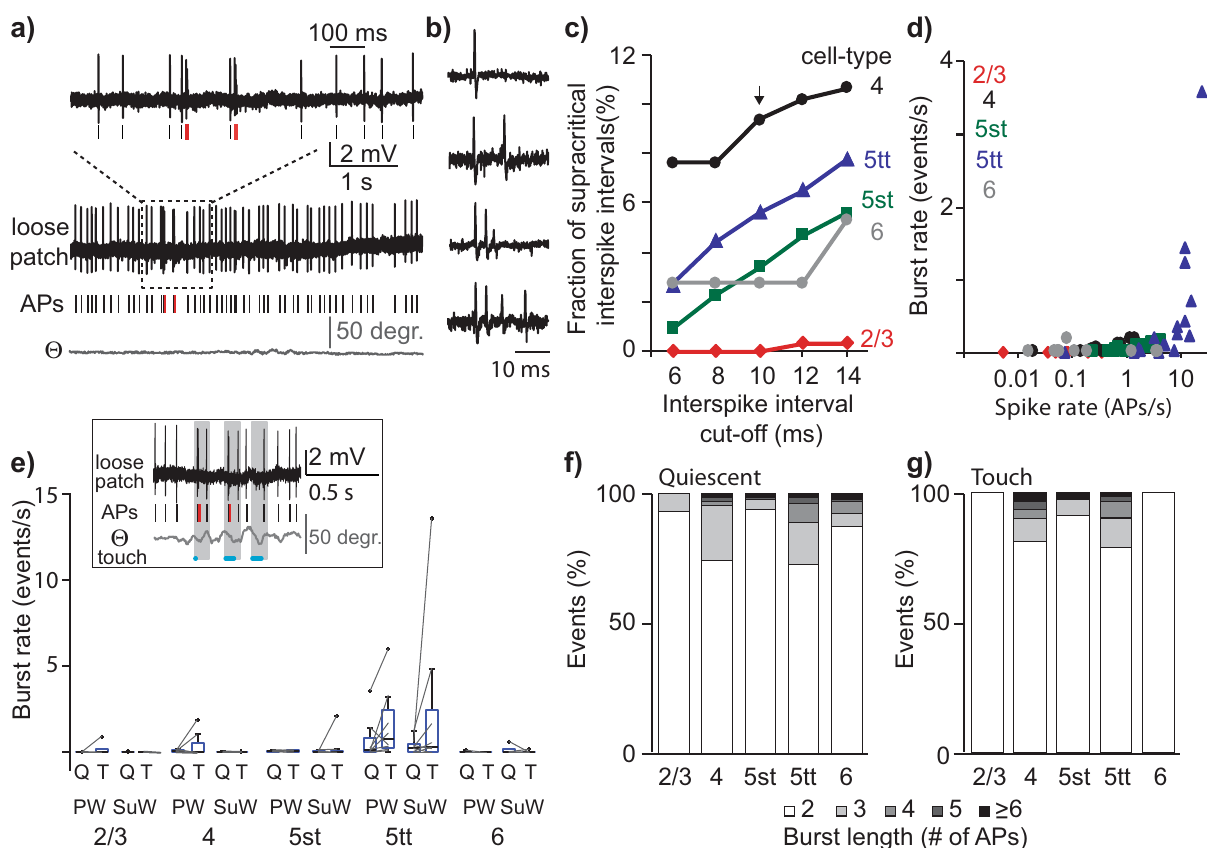
Fig. 4 Cell-type-speci fi c high-frequency bursting. a Spiking activity of an example L5tt recording during quiescent episodes with single spikes indicated by black ticks and spikes at supracritical frequency ( ≥ 100 Hz) by red ticks, respectively. b Example traces of a single spike (upper trace) and burst events of 2 – 4 consecutive spikes at supracritical frequency ( ≥ 100 Hz). c The median fraction of high-frequency bursts detected during spontaneous spiking activity (quiescent episodes) depends on the cutoff criteria (1st – 3rd quartile range omitted for clarity). Arrow indicates the cutoff criterion used in subsequent analyses. d Scatterplot illustrating spike rate (APs/s) of individual recordings during quiescent episodes and burst rate (events/s) (Pearson correlation, Rho 0.66, p < 0.0001). e Burst rate (events/s) during quiescent (Q) and touch (T) windows, respectively for different excitatory cell types. Boxplots show median as central mark, the edges of the box the 25th and 75th percentiles, the whiskers extend to the most extreme data points, and the outliers are plotted individually. f Burst length as the number of action potentials (APs), relative to the total number of events observed during quiescent windows. g Analogous to (f) , but for Touch